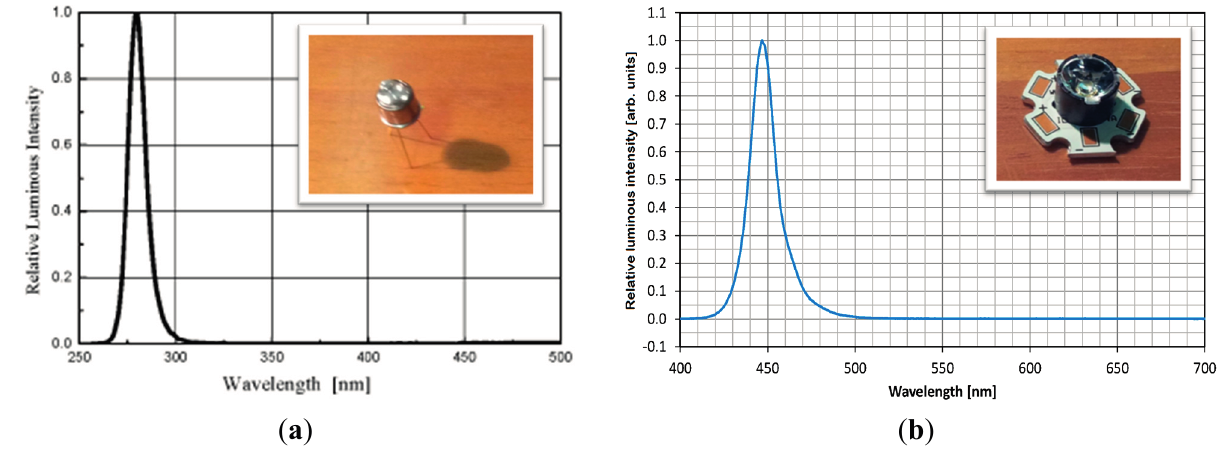
Figure 1. LEDs used for fluorescence excitation: ( a ) UV-LED emitting 280 nm; ( b ) blue LED emitting 450